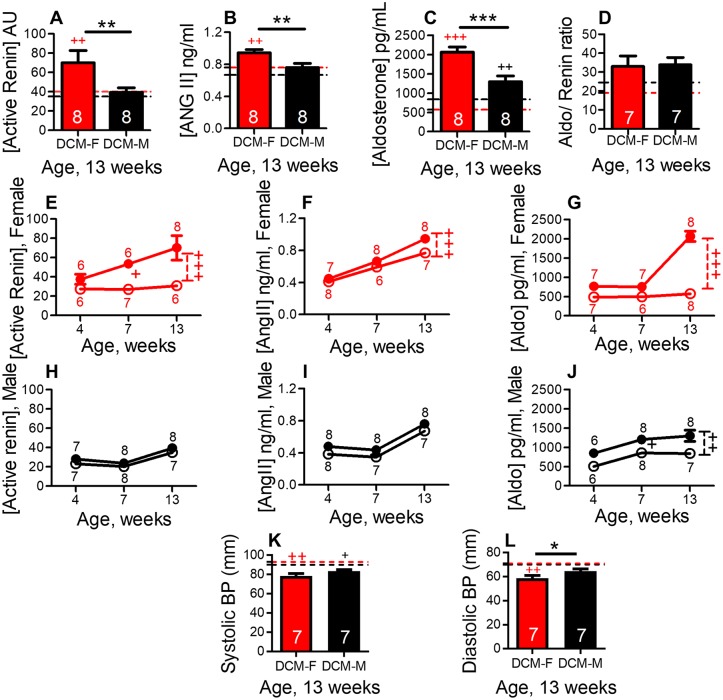
Sex differences in the activation of RAAS axis in mice with DCM.Plasma levels of (A) active renin (B) angiotensin II and (C) aldosterone in female and male DCM and WT control mice, at 13 weeks, determined by ELISA. (D) Aldosterone to active plasma renin ratio in DCM and WT mice. The number of DCM mice is indicated. Female and male base line levels were indicated by red and black dotted line respectively (WT mice, n = 6–8 per group). Plasma active renin levels (arbitrary units) in female (E) and in male (H), angiotensin II plasma levels in female (F) and in male (I), Aldosterone plasma levels in female (G) and in male, DCM and WT control mice (J). The number of animals per group at each time point is shown. Female and male mice with DCM (closed symbol) female and male WT mice (open symbol). Systolic blood pressure (K) and diastolic blood pressure (L) in female and male, DCM and WT mice. The number of DCM mice is indicated, WT mice, n = 4–8 per group. ***P<0.001, **P<0.01, *P<0.05 (DCM female vs. DCM male). +++P<0.001, ++P<0.01, +P<0.05 (DCM vs WT).